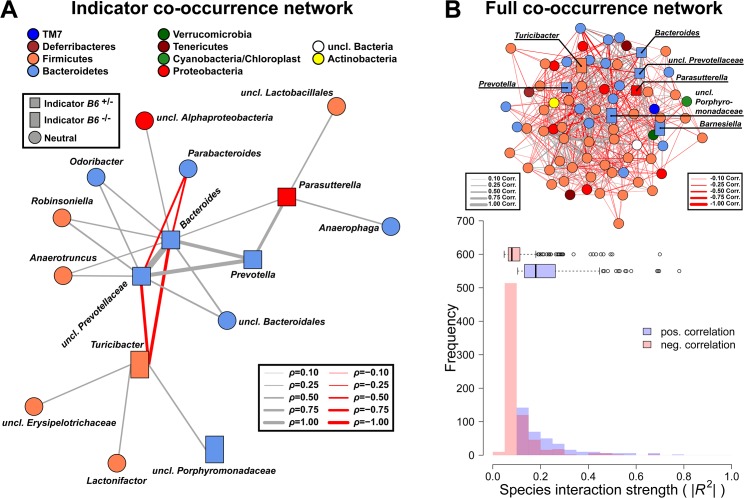
Targeted co-occurrence network analysis of indicator genera and overall network analysis.(A) Indicator genera for B6 genotypes were correlated to abundances of the remaining community members to investigate proximate interactions among indicator genera and the surrounding community (interactions are Spearman correlations see S6 Table; square - B6
+/- indicator, rectangle—B6
-/- indicator, circle—no indicator/neutral). (B) Microbial co-occurrence network based on genera abundances (only significant associations shown), with indicator species highlighted. Microbial communities show significant higher interaction strength among positive interactions (i.e. potential mutualistic; SPF: W = 489396, P < 2.20 × 10−16; Wilcoxon test). However, the higher frequency of negative weak interactions overall has a stabilizing effect preventing the communities from collapsing (positive/negative interactions = 0.482; # P < 0.100, * P < 0.050, ** P < 0.010, *** P < 0.001).